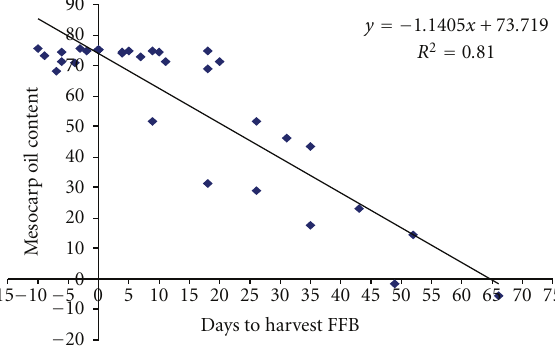
Figure 13: Overall estimation model of mesocarp oil content and harvesting days